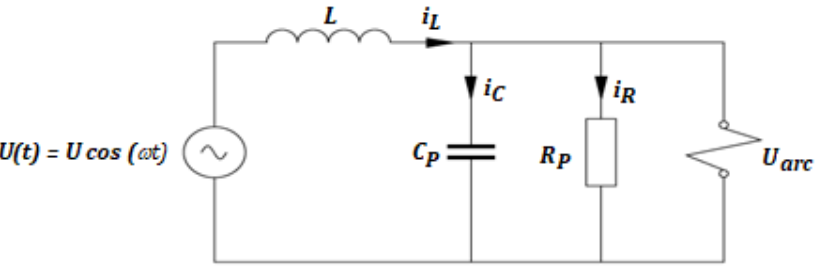
Figure 1. Electrical network elements connected to the circuit-breaker terminals.